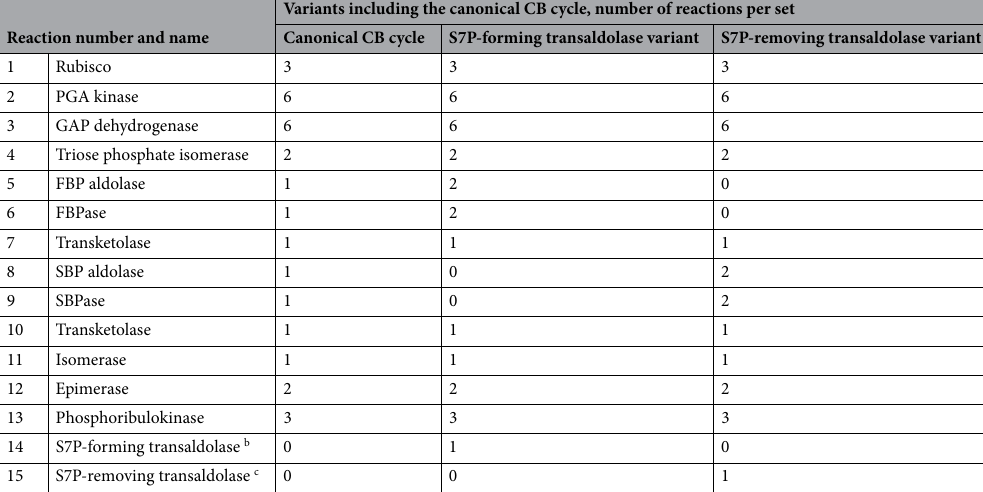
Table 2. Set of reactions to form GAP from CO 2 constituting each of the canonical CB cycle, the S7P-forming transaldolase variant and the S7P-removing transaldolase variant. GAP, glyceraldehyde 3-phosphate; CB cycle, Calvin-Benson cycle; S7P, sedoheptulose 7-phosphate a . a For other abbreviations, please see Table 1. The FBP and SBP formation reactions catalyzed by aldolase are named FBP aldolase and SBP aldolase, respectively. b E4P + F6P → S7P + GAP. c S7P + GAP → E4P + F6P.